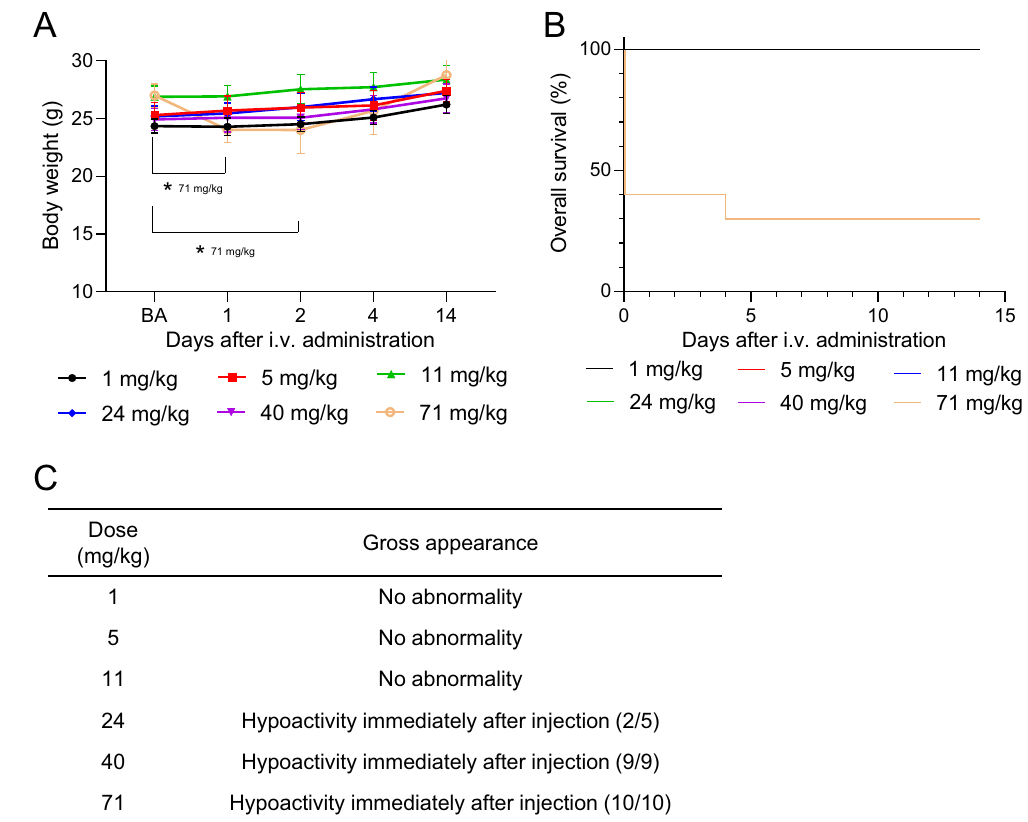
Fig. 4 Observation results of the mice after intravenous administration with HMS particles. A Body weight changes. * p < 0.05 Student ’ s t test (vs. BA). B Overall survival. The survival curves for all except 71 mg/ kg administration group were overlaid because no mice were dead in